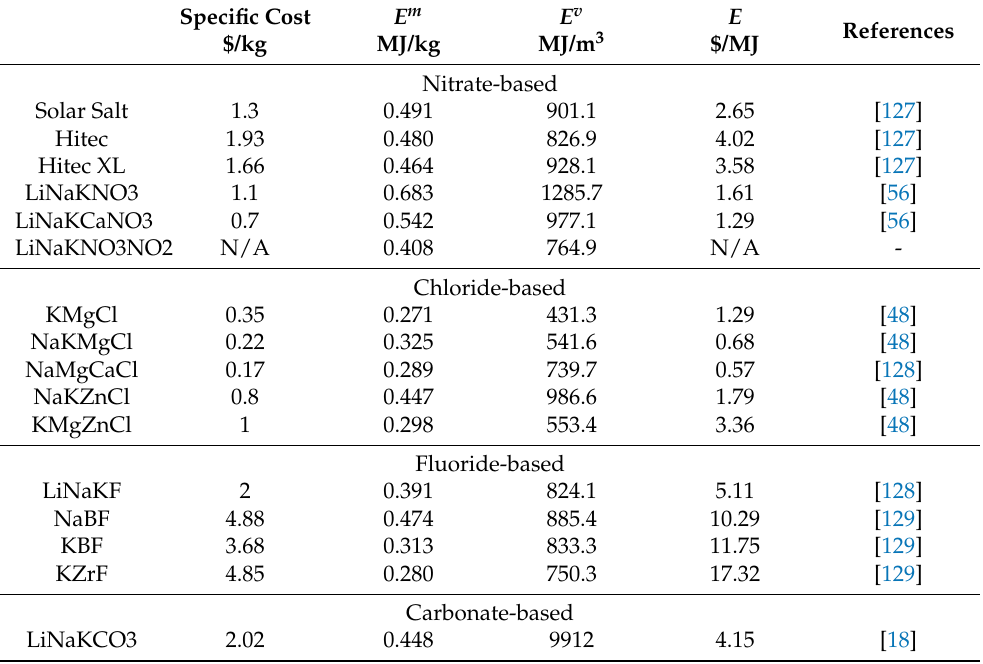
Table 3. In this analysis, Solar Salt was used as a reference for comparison issues, and 700 ◦ C was considered the maximum temperature allowed. Table 3. Specific cost and energy of selected molten salt TES